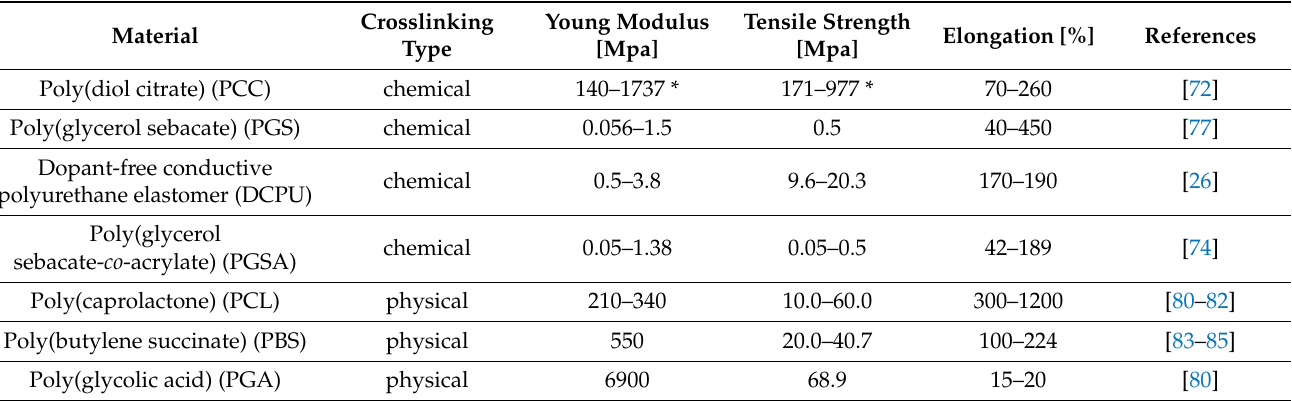
Table 2. Mechanical properties of selected synthetic